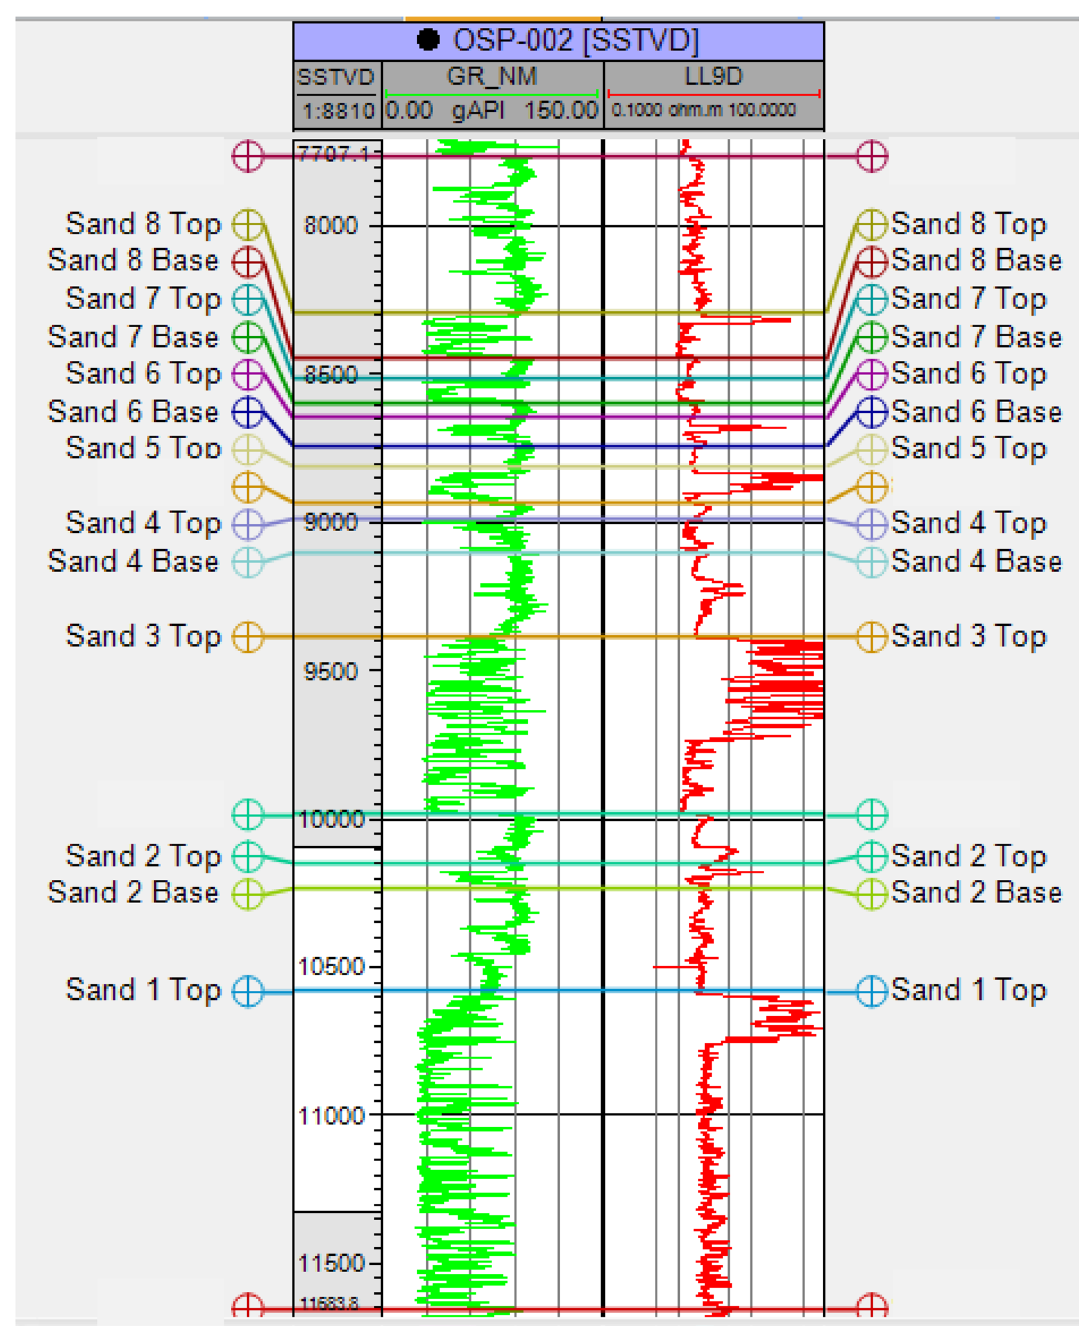
Fig. 7 Identified hydrocarbon bearing